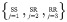
Compartmental description.The model comprises five life-stages of three mosquito genotypes that are represented by rectangular boxes. The genotypes are indexed by j as follows: {SSj=1,SRj=2,RRj=3}. Arrows connecting two boxes represent mosquitoes of a specific life stage maturing into another life stage, with the appropriate transition rate. Outward arrows represent removal of individuals from that specific life stage due to natural or insecticide-caused death. The thicker arrow connecting the Parous stage to the Egg stage boxes represents an influx of eggs arising from random, non-preferential mating of parous mosquitoes. The Intra-Specific Competition box represents a logistic type competition among larvae of the three genotypes. Note that interaction among different genotypes occur only at the mating and larval stages.